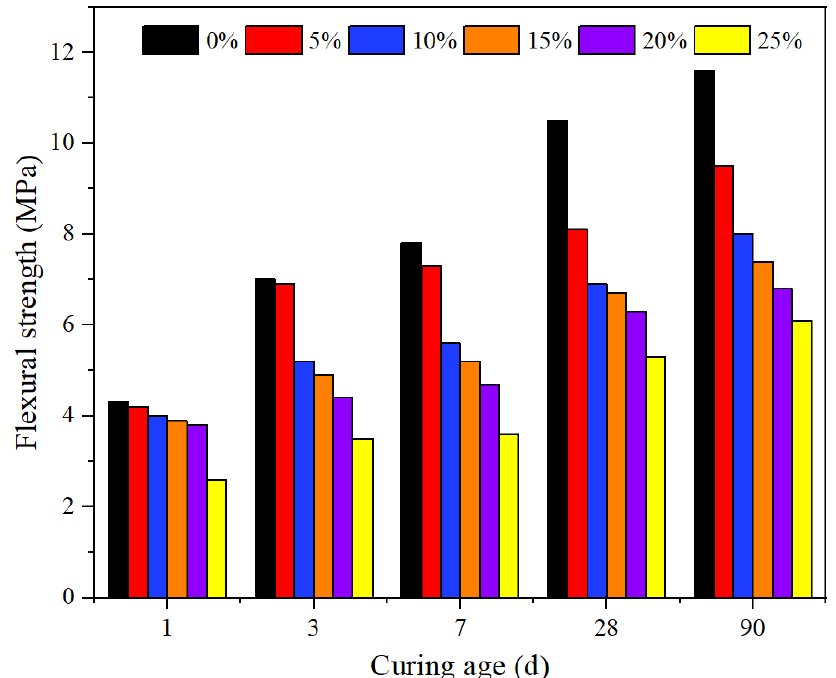
Figure 6. The effect of FBA content on the flexural strength of MPC mortars at different curing ages.